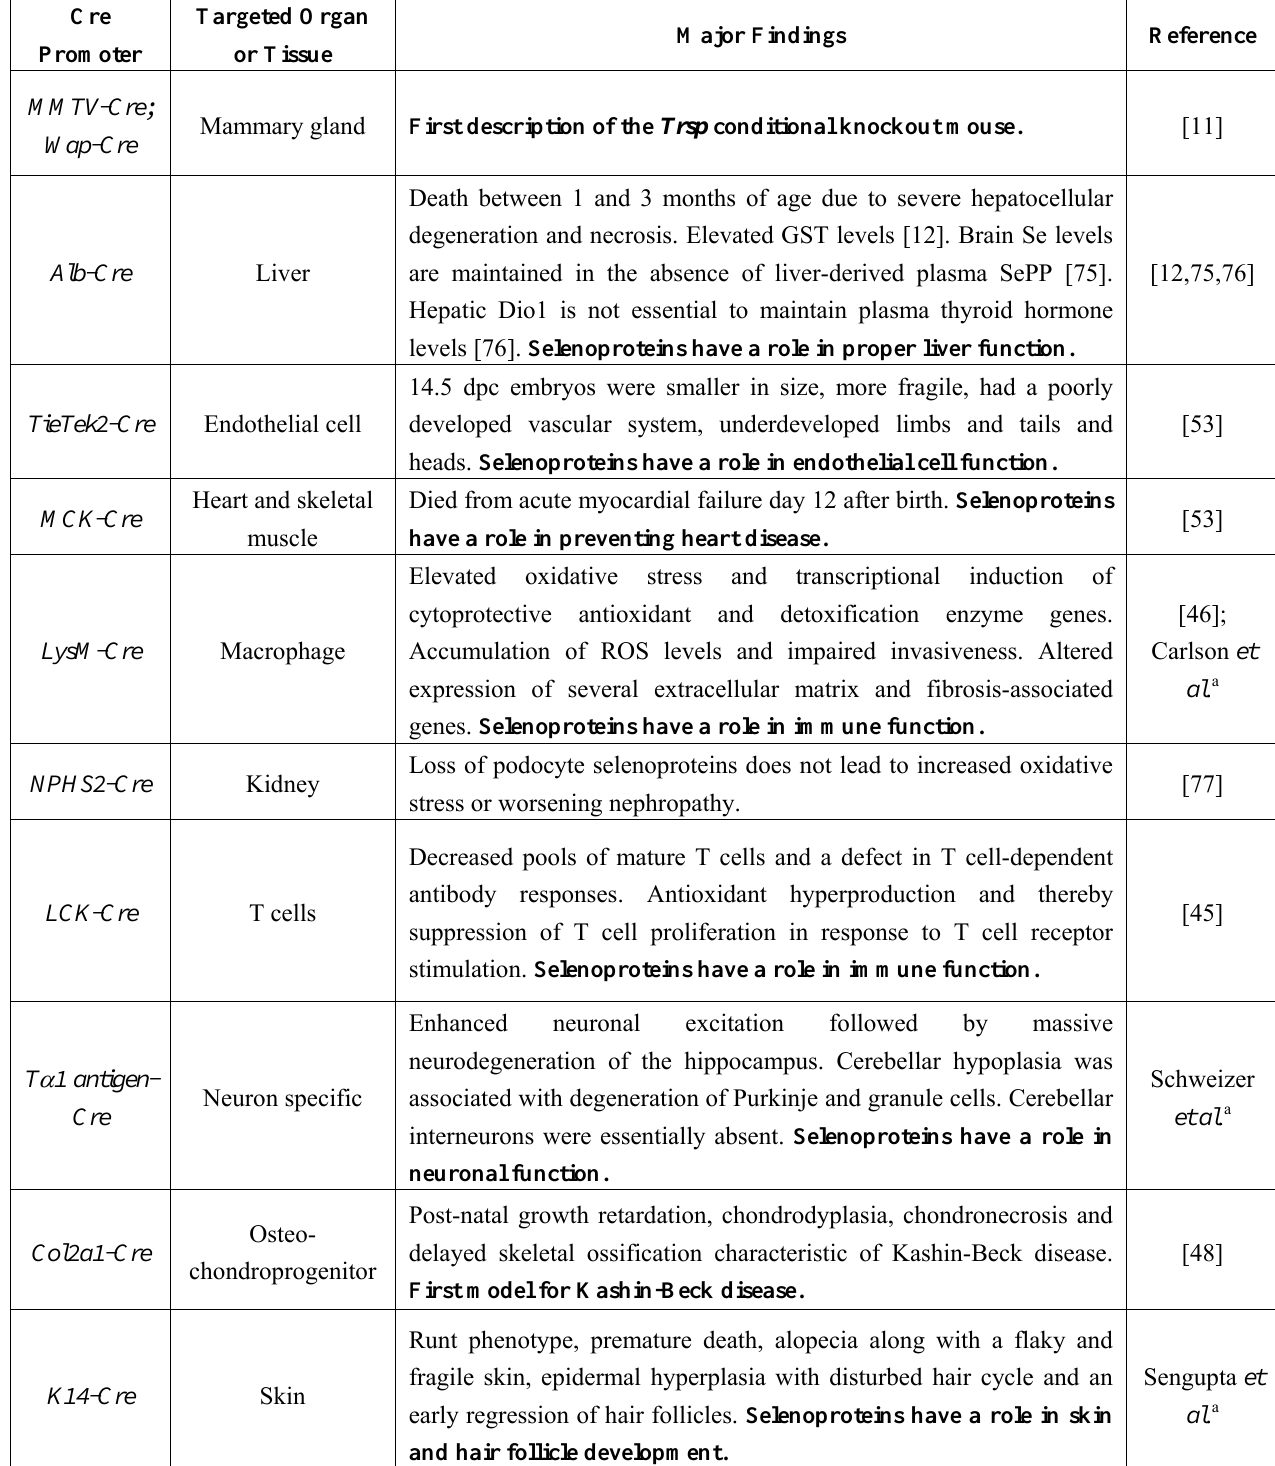
Table 2. Trsp conditional knockout mouse